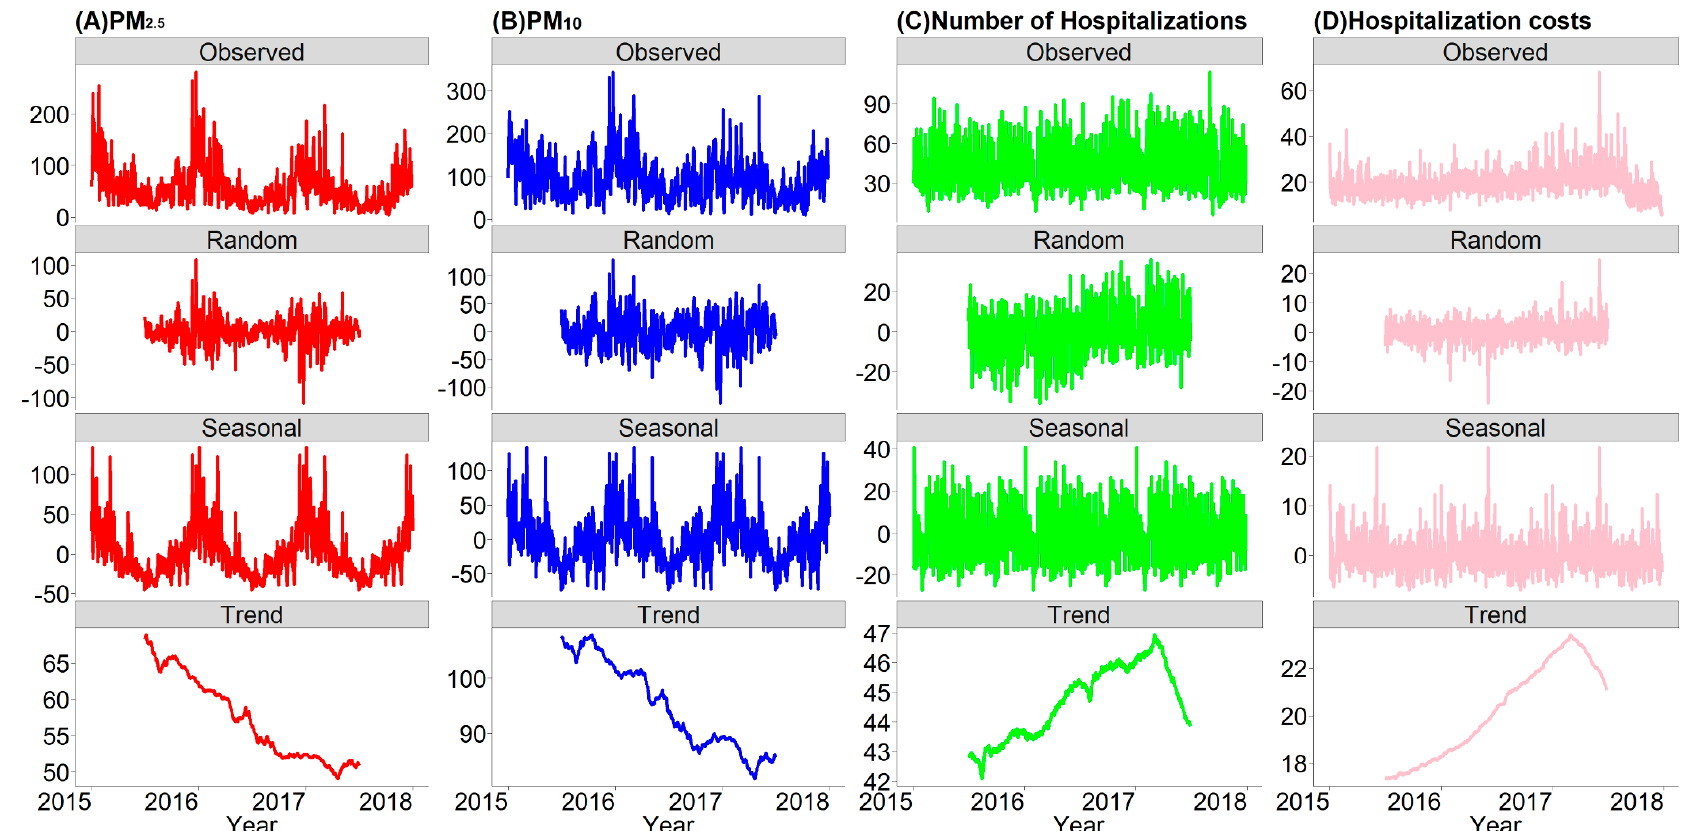
Figure 1. The decomposed distributions for the daily concentrations of PM 2.5 and PM 10 , daily hospitalizations and case-average hospitalization costs due to CVD in Wuhan, China, from 2015–2017. ( A ) daily concentration of PM 2.5 ; ( B ) daily concentration of PM 10 ; ( C ) daily number of hospitalizations; ( D ) case-average hospitalization costs.